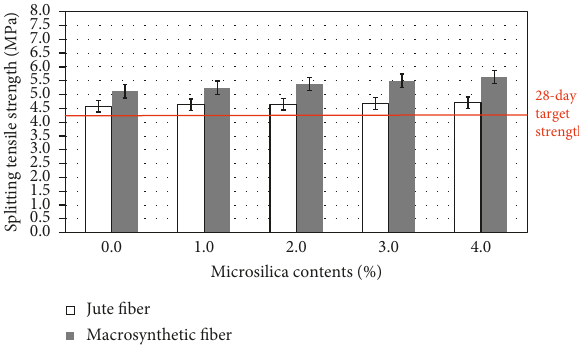
Figure 7: Splitting tensile strength of